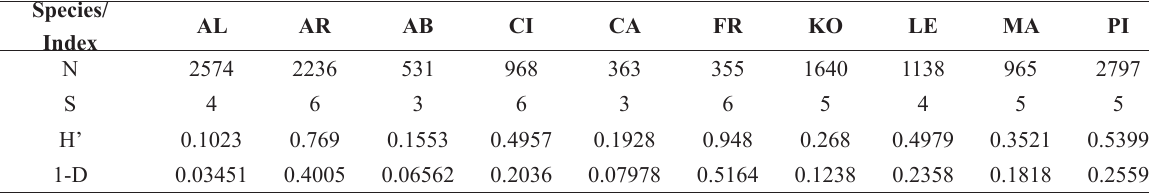
Number of scales (N), richness (S), Shannon-Wiener index (H ’ ) and diversity Simpson (1-D) in ten varieties of olive trees ( Olea europaea L.), 2013-2014, Encruzilhada do Sul, RS. (AL – Alfafara; AR – Arbequina; AB – Arbosana; CI – Cipressino; CA – Coratina; FR – Frantoio; KO – Koroneike; LE – Leccino; MA – Manzanilla; PI – Picual).